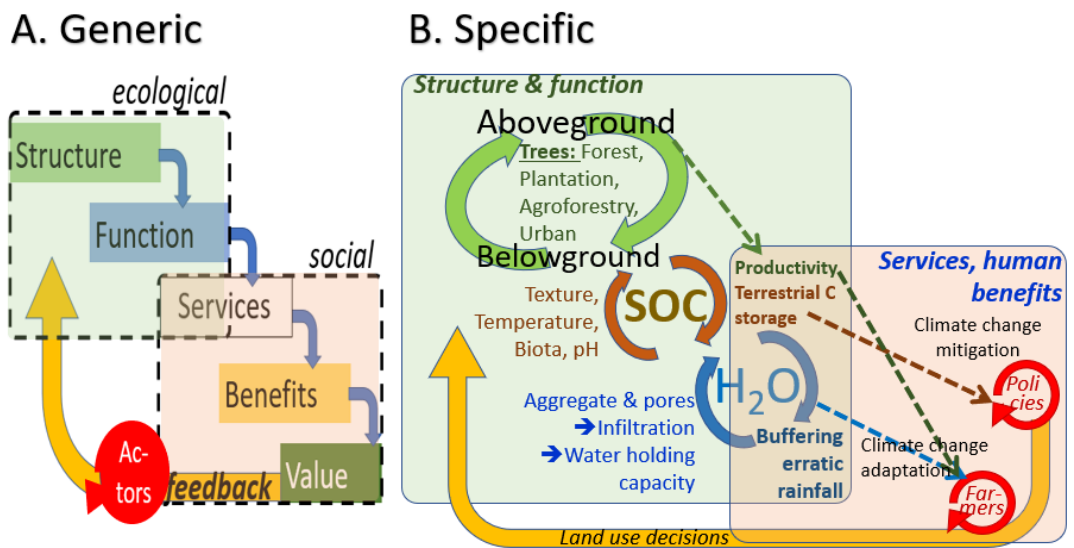
Figure 1. ( A ) Cascade representation of ecosystem structure and function, interacting with social systems via ‘ecosystem services’ [14]; ( B ) Relationship between the agroecosystem structure (observable), function (inferred), and human benefits (policy focus) in relation to the growth cycle of trees, the formation, and the decay of soil organic carbon (SOC), climate change, and the water (H 2 O) cycle.